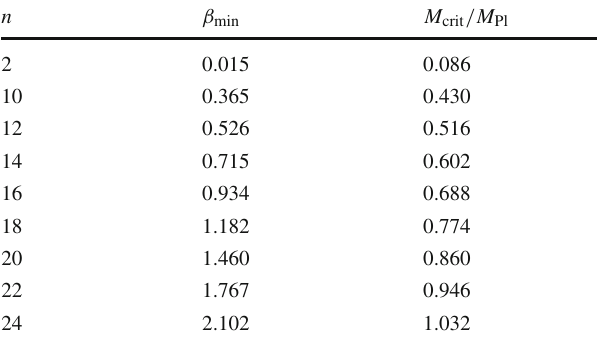
Table 1 This shows the minimum value of β required for r + to have a smooth minimum for a given value of the charge n . If this condition is violated, the solution has the RN form with the black hole having the minimum mass